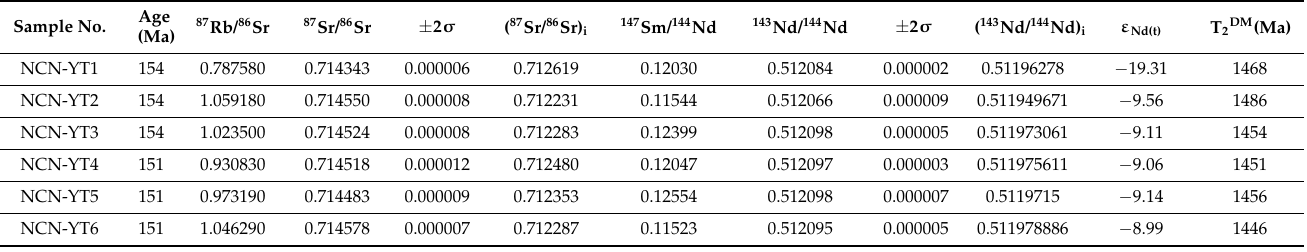
Table 4. Sr–Nd isotopic data for the Nuocang